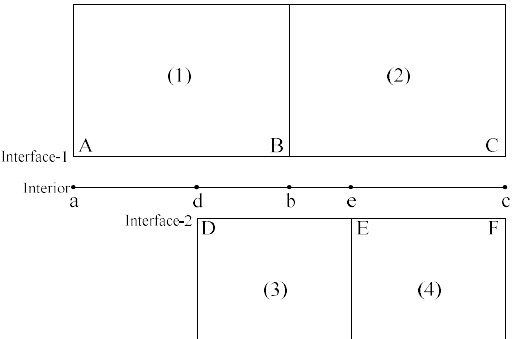
Figure 1. Sliding mesh diagram.